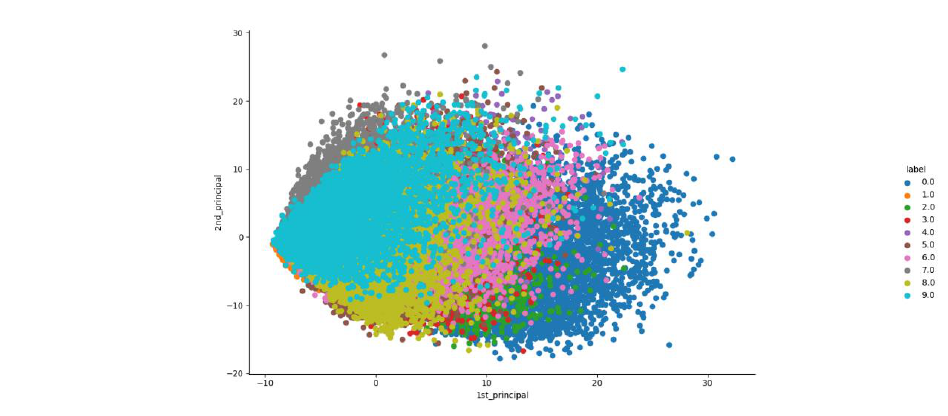
Figure 5 – 2D data points visualization Рис. 5 –Визуализация точек 2D данных Слика 5 – Визуализација тачака 2Д